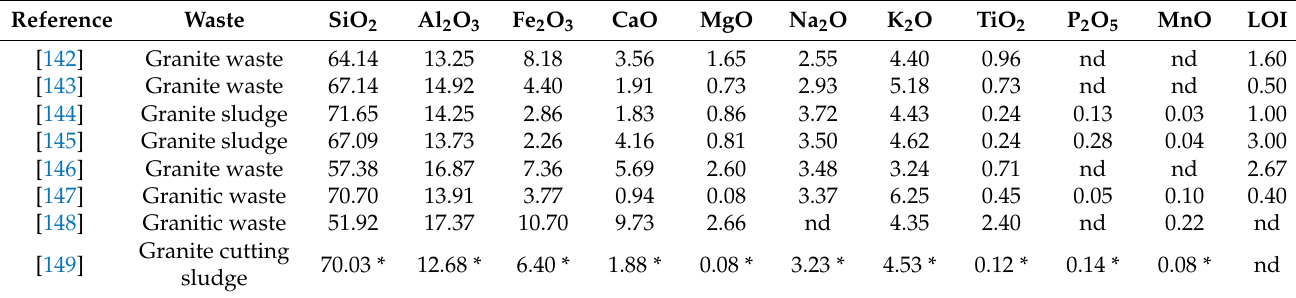
Table 19. Chemical composition (expressed wt.% oxide) of granite